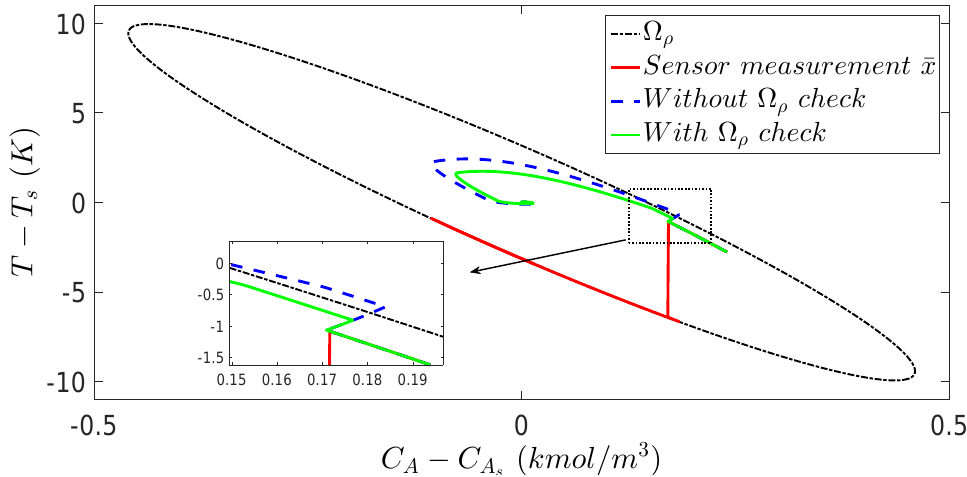
Figure 11. The state-space profile for the closed-loop CSTR with the initial condition (0.24, − 2.78), where a min-max cyber-attack is detected by the NN-based detection system and mitigated by the LMPC of Equation (14).